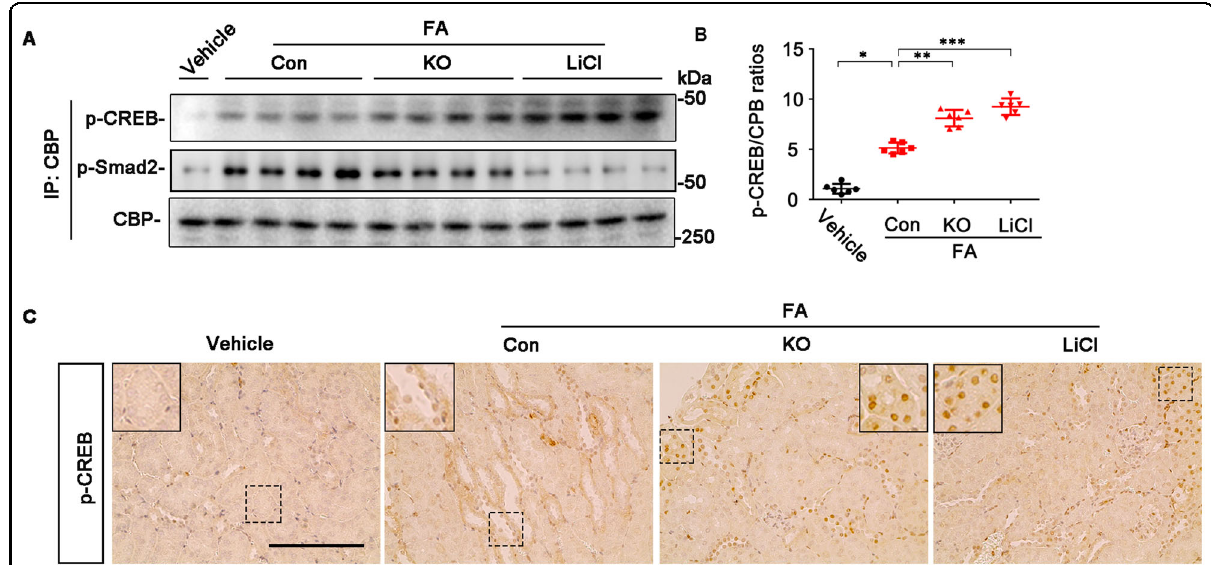
Fig. 8 GSK3 β inhibition in mice with FA nephropathy increases CREB activity in renal tubules and favors CREB competition with Smad for binding to CBP. A Kidney homogenates were subjected to immunoprecipitation with the anti-CBP antibody and immunoprecipitates were processed for immunoblot analysis for indicated molecules. Representative immunoblots were shown. B Densitometric analysis of the levels of p-CREB that co-precipitated with CBP, as normalized to the CBP levels and expressed as fold changes relative to the control group. *P, **P, ***P < 0.01 ( n = 6, ANOVA followed by Tukey ’ s tests). C Representative micrographs of immunohistochemistry staining for p-CREB. Scale bar = 100 μ